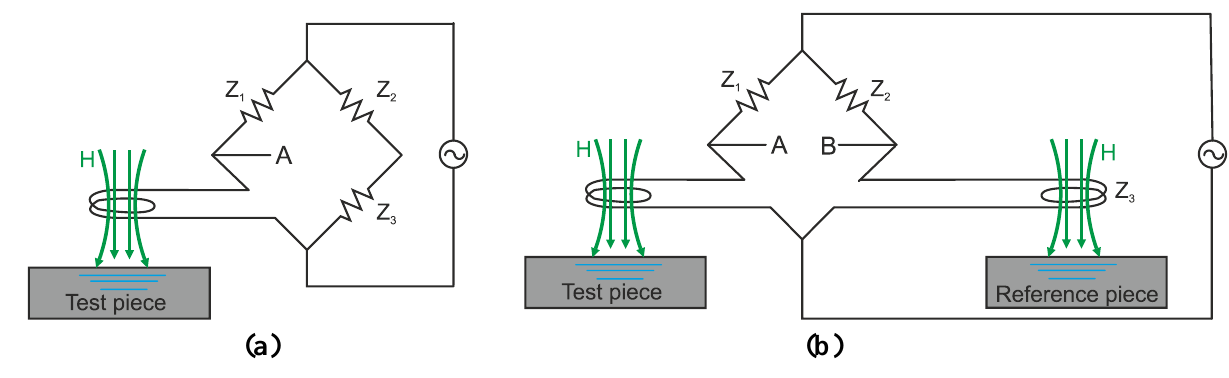
Figure 26. (a) Unbalanced bridge connection. (b) Balanced bridge